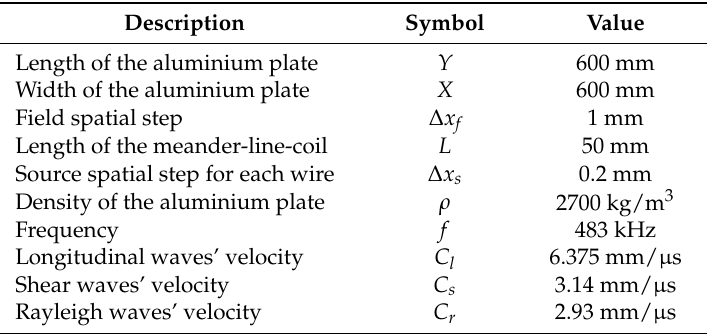
Table 1. Detailed parameters used for the EMAT-US modelling.